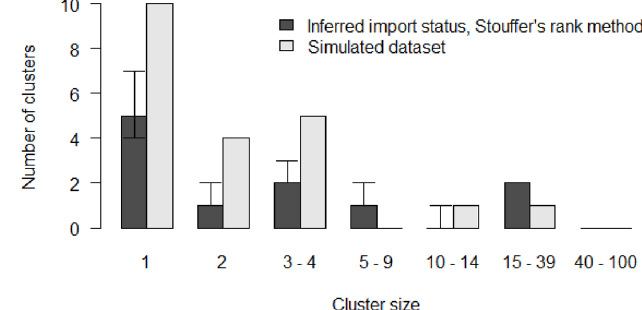
Figure 7. Comparison of inferred cluster size distribution with the reference data.